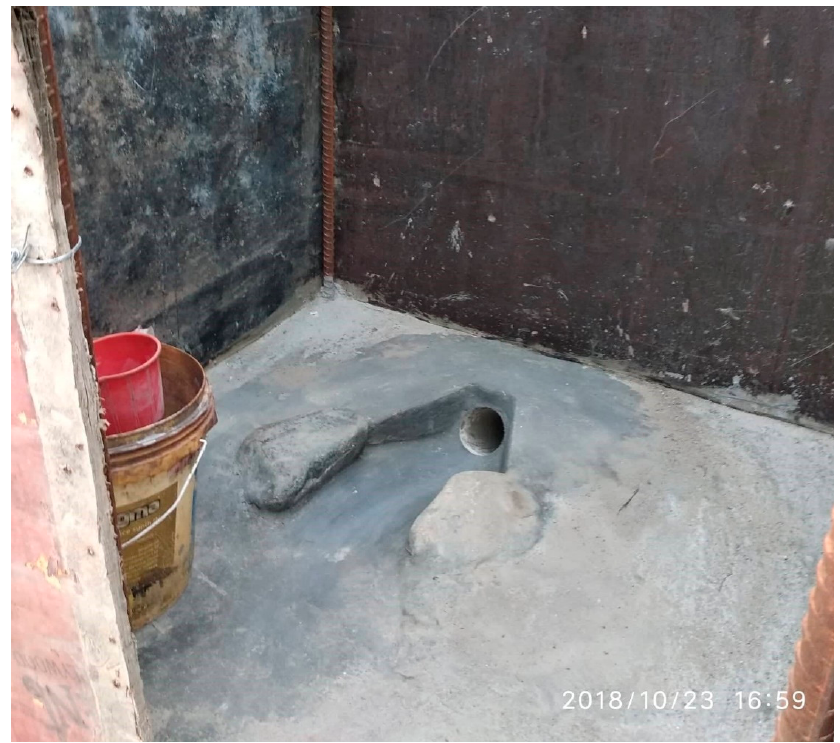
Figure 2. Example of a low-cost improved sanitation facility in a construction site. Photo credit: Sudeep Sharma.